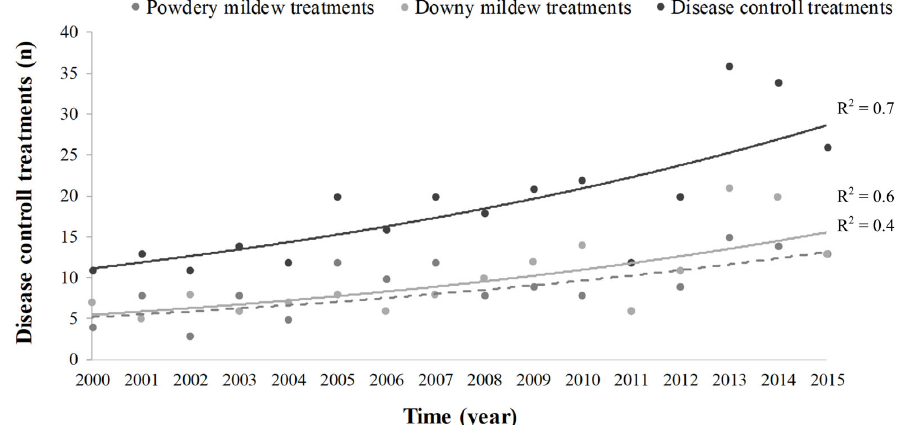
Figure 8. Total disease control treatments (continued black trend lines) and specific treatments for powdery ( Erysiphe necator ) (dotted gray trend lines) and downy mildew ( Plasmopara viticola ) (continued grey trend lines) carried out in each growing season in the western sub ‐ area.